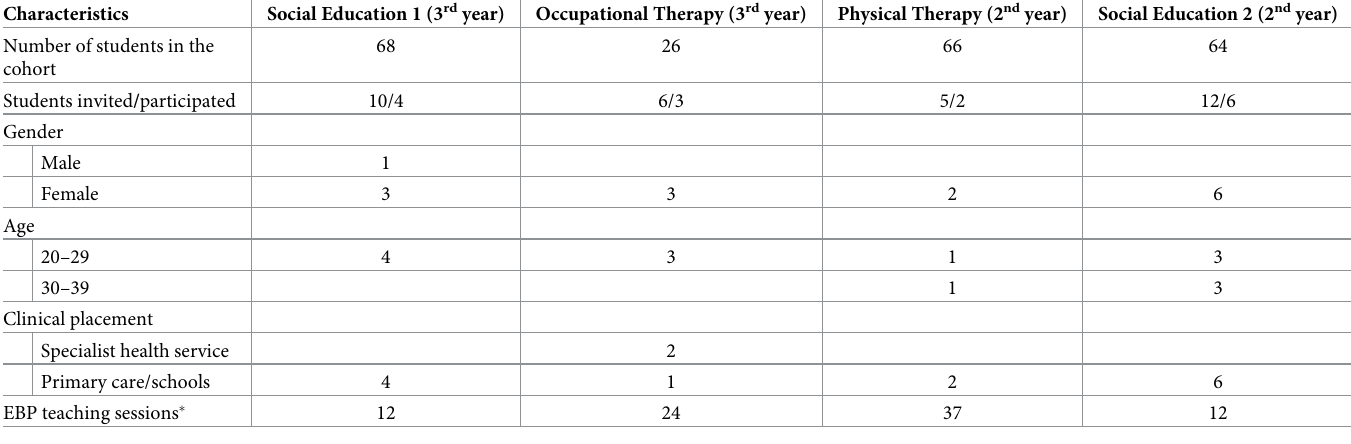
Table 1. Characteristics of